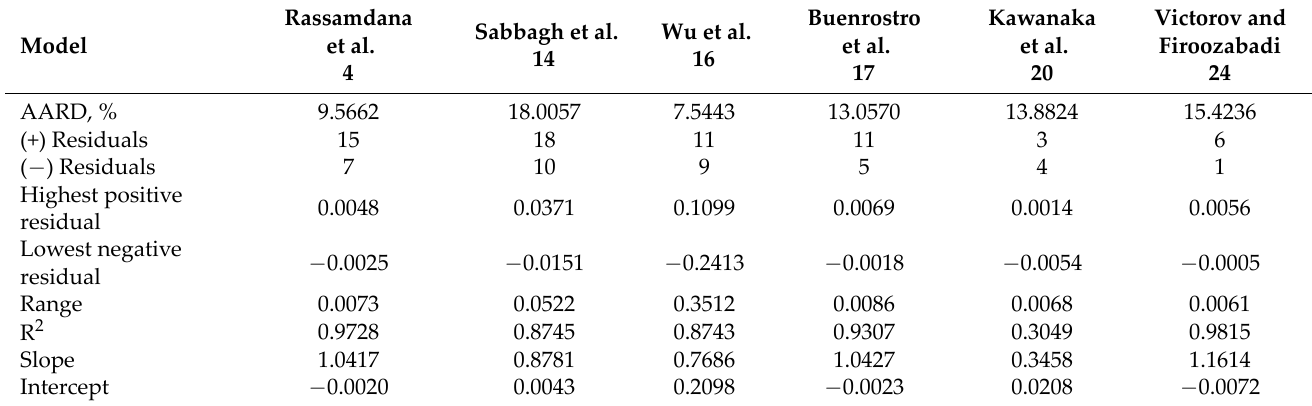
Table 8. Statistical analysis for models to calculate asphaltene precipitation by effects of